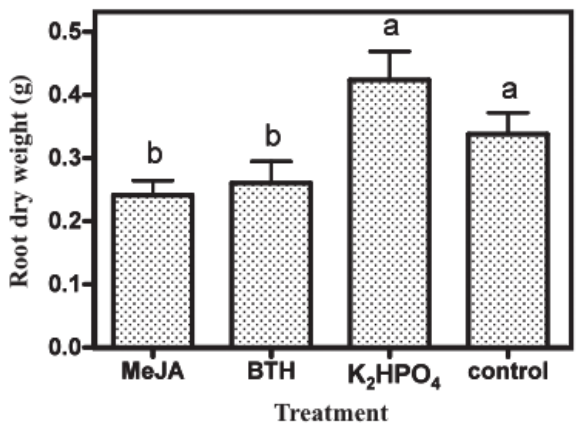
Figure 3. Effect of soaking melon seeds in methyl jas- monate (MeJA), acybenzolar-S-methyl (BTH) and di- potassium hydrogenphosphate (K biomass of melon plants grown in soil artificially inocu - lated with Monosporascus cannonballus . data are the means of two separate experiments ± SE. data followed by the same letters are not significantly different at P ≤0.05 (Tuckey test ).